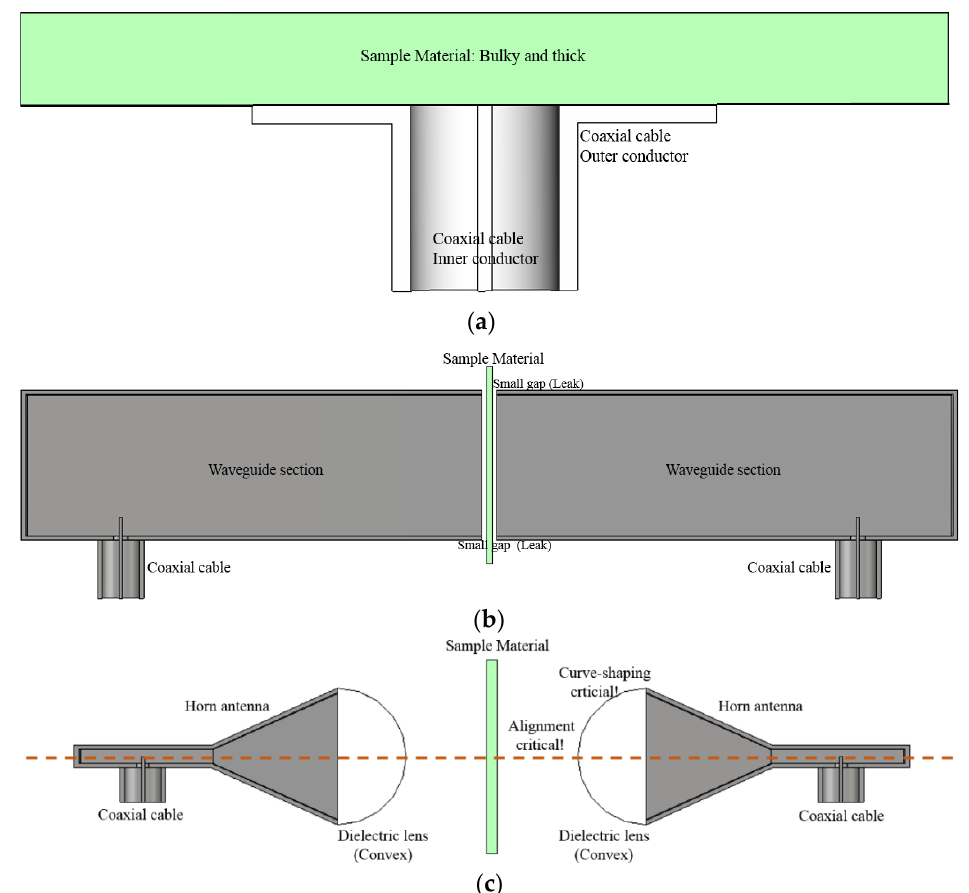
Figure 2. The most commonly used test setups to find the permittivity of a dielectric sample ( a ) Open-ended coaxial line ( b ) Embedding in a waveguide cavity ( c ) Line-of-sight link between horn antennas.